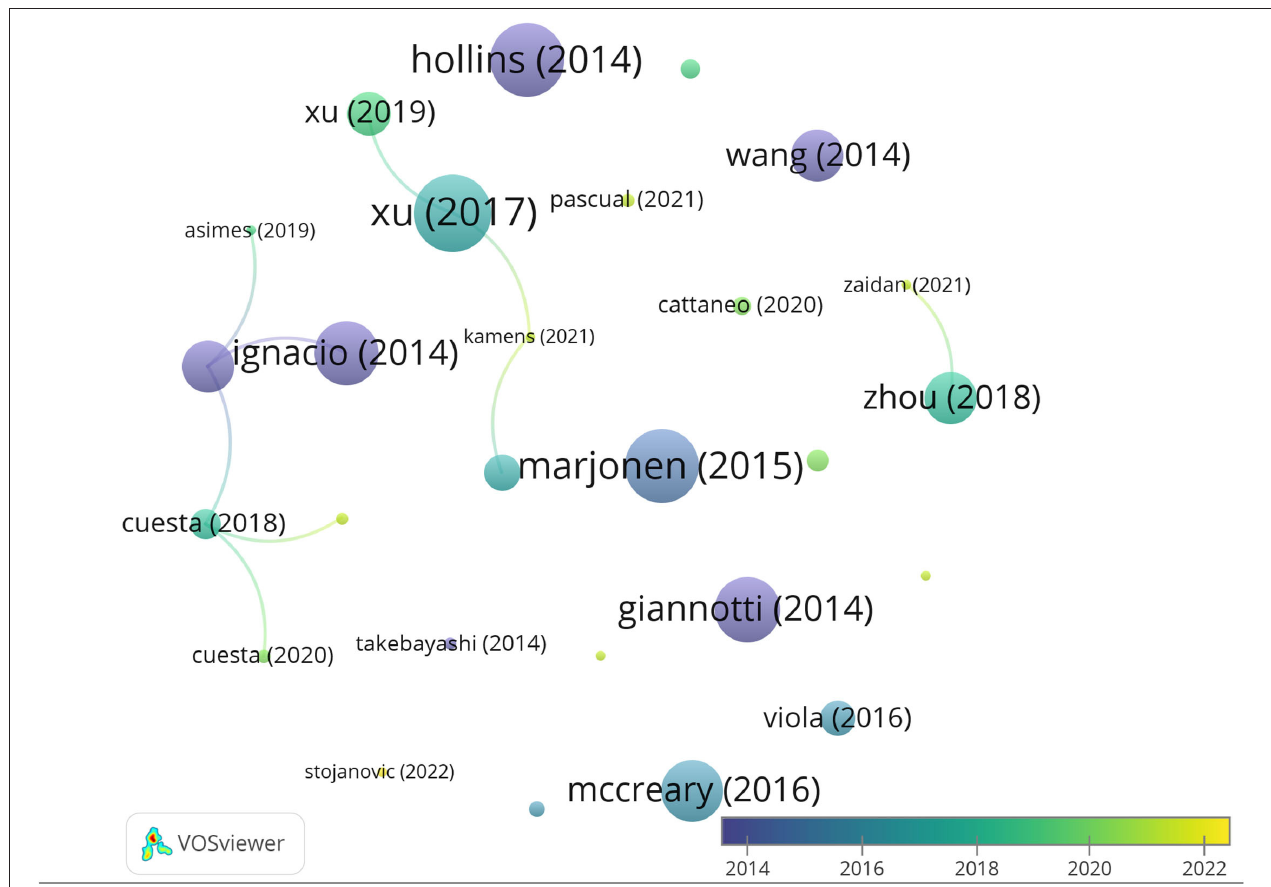
FIGURE 4 | Network data map of the articles’ citations. Point size represents the number of citations received and colors the publication year. Lines represent the number of co-citations evidencing only three